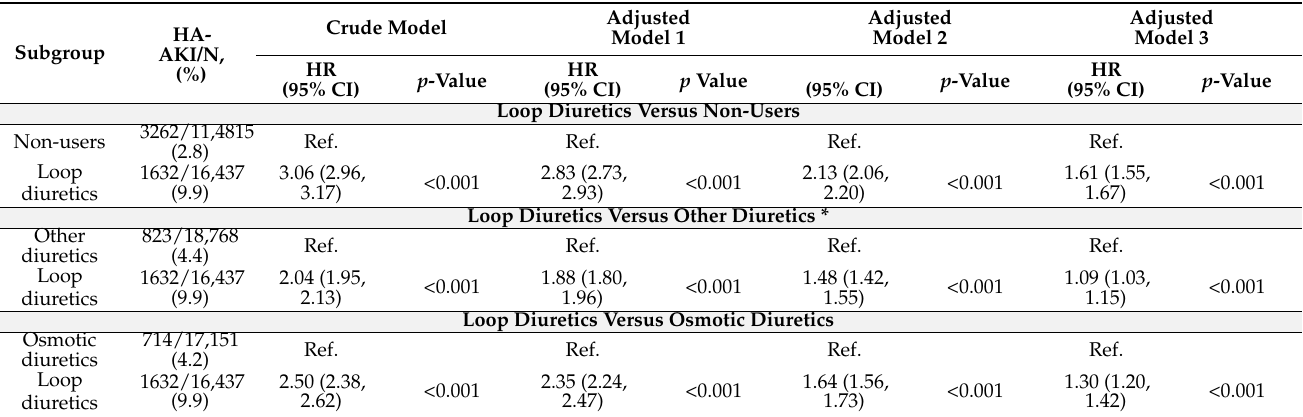
Table 2. The association between treatment with diuretics and the risk of